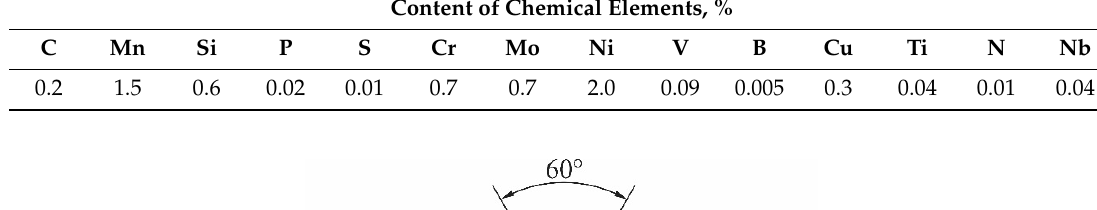
Table 1. Chemical composition of S690 steel